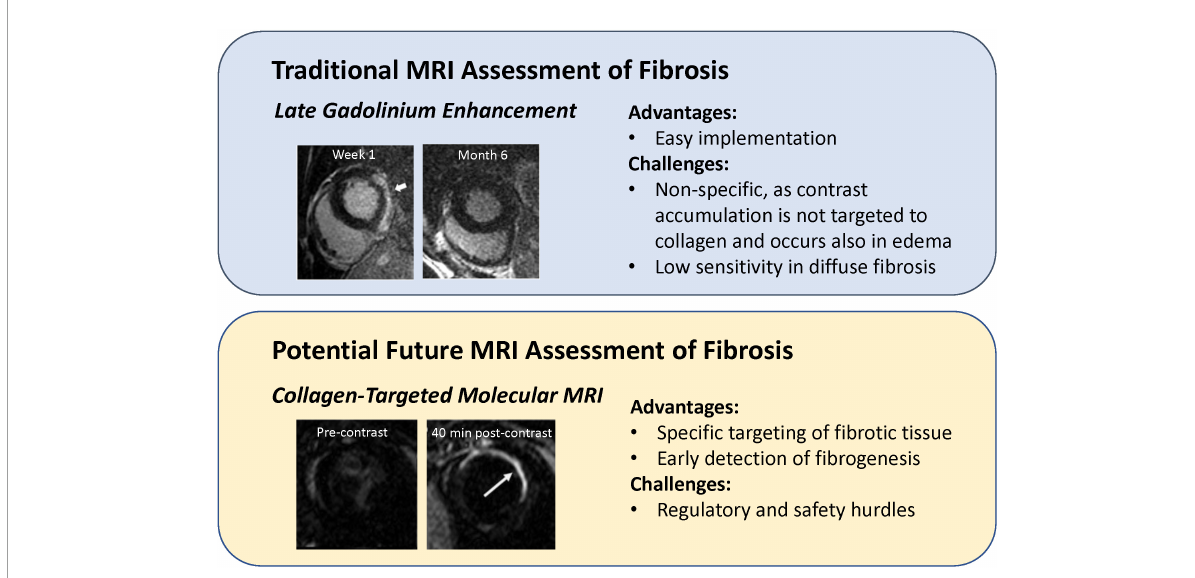
FIGURE4 Comparison of targeted imaging of myocardial fibrosis to conventional late gadolinium enhancement. (Upper panel) Late gadolinium enhancement (LGE) in an acute setting does not mean definitive fibrosis, as LGE at 1 week after onset of acute myocarditis disappeared at 6-month follow-up [this research was originally published in Aquaro et al. (79)]. (Lower panel) Myocardial scar injected with a fibrosis-targeted agent, EP-3533, is not visible pre-contrast but is clearly visible 40 min after contrast injection [this research was originally published in Caravan et al.